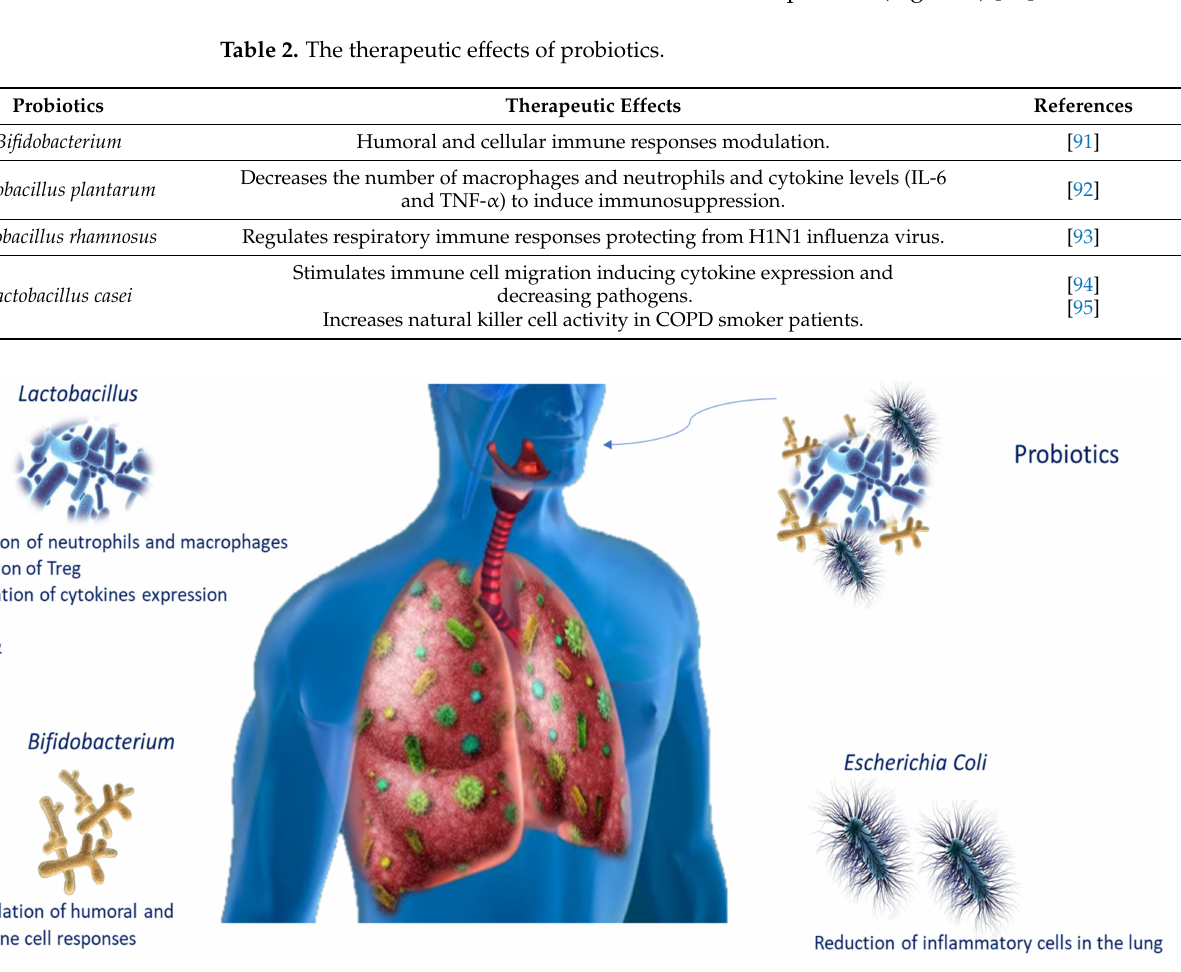
Figure 3. Probiotic modulation during lung infections. Schematic representation of probiotic mod- ulation of immune responses during lung infections. Abbreviations: tumour necrosis factor-alpha (TNF- α ); interleukin-6